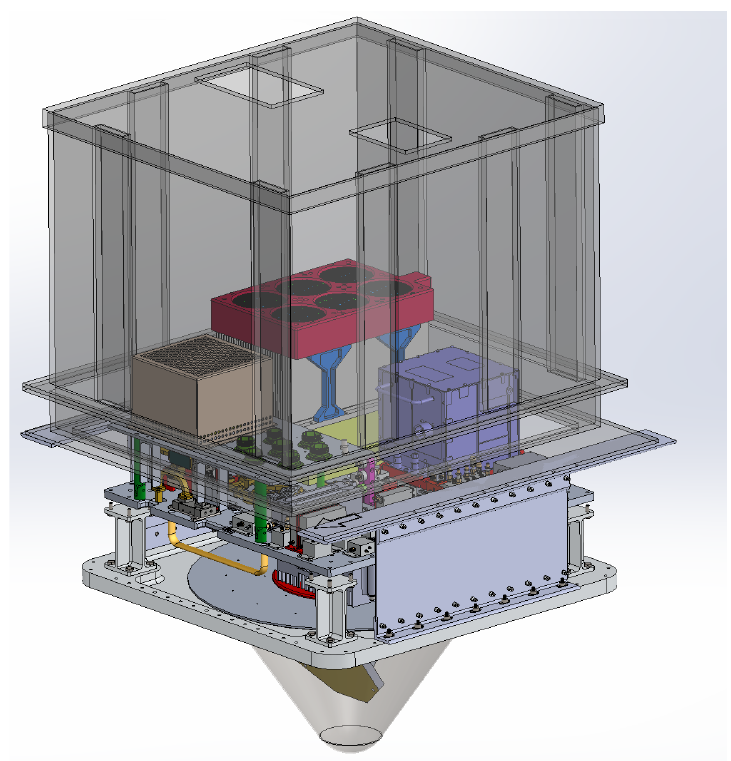
Figure 4. The DopplerScatt instrument in its flight configuration. The compact instrument assembly is easy to install in the nadir-looking aircraft port. A notional pressure box extending around the instrument is shown in transparent